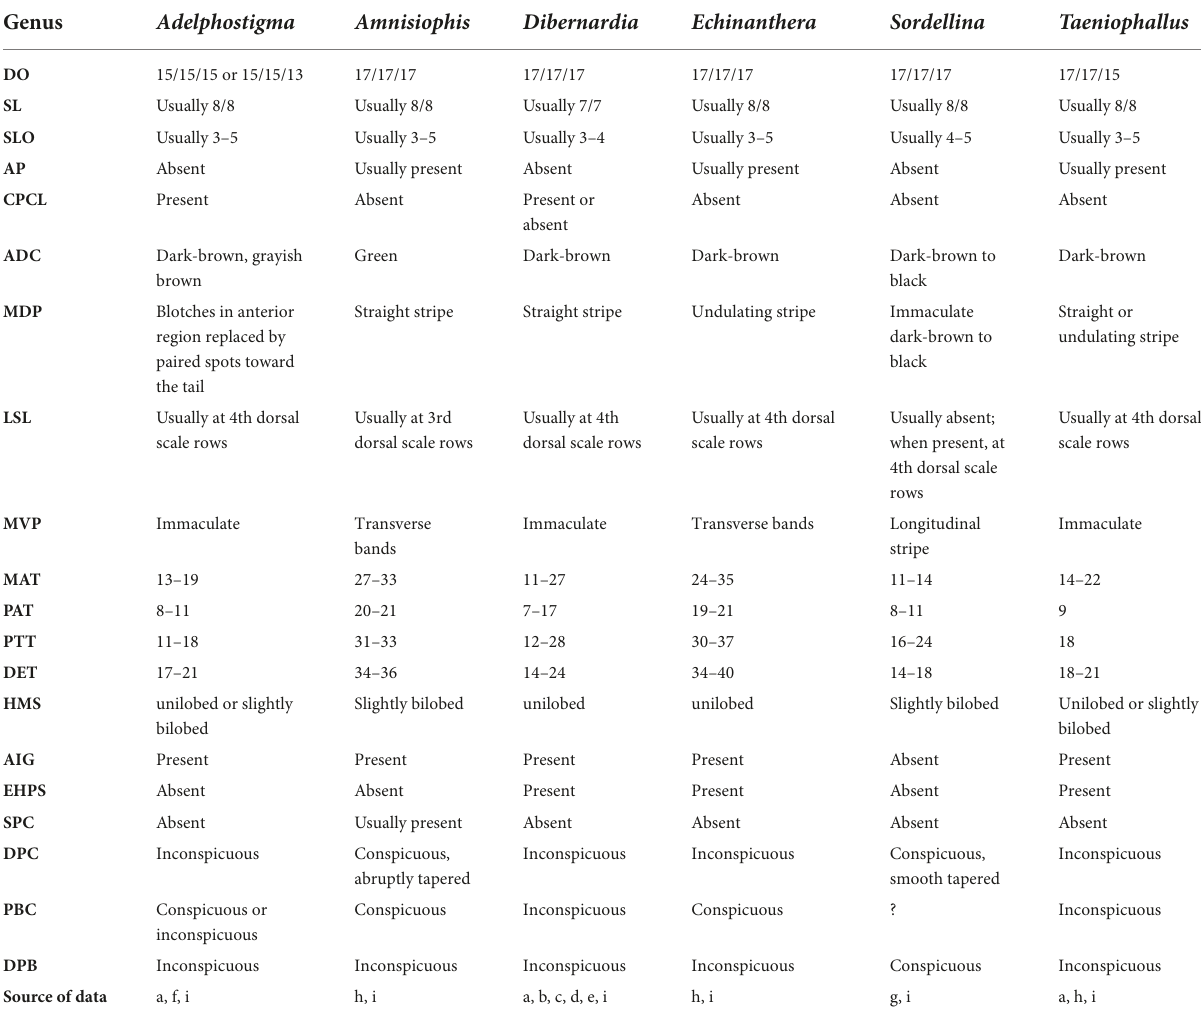
TABLE 1 Comparative morphology within the new taxonomic arrangement for Echinantherini genera.